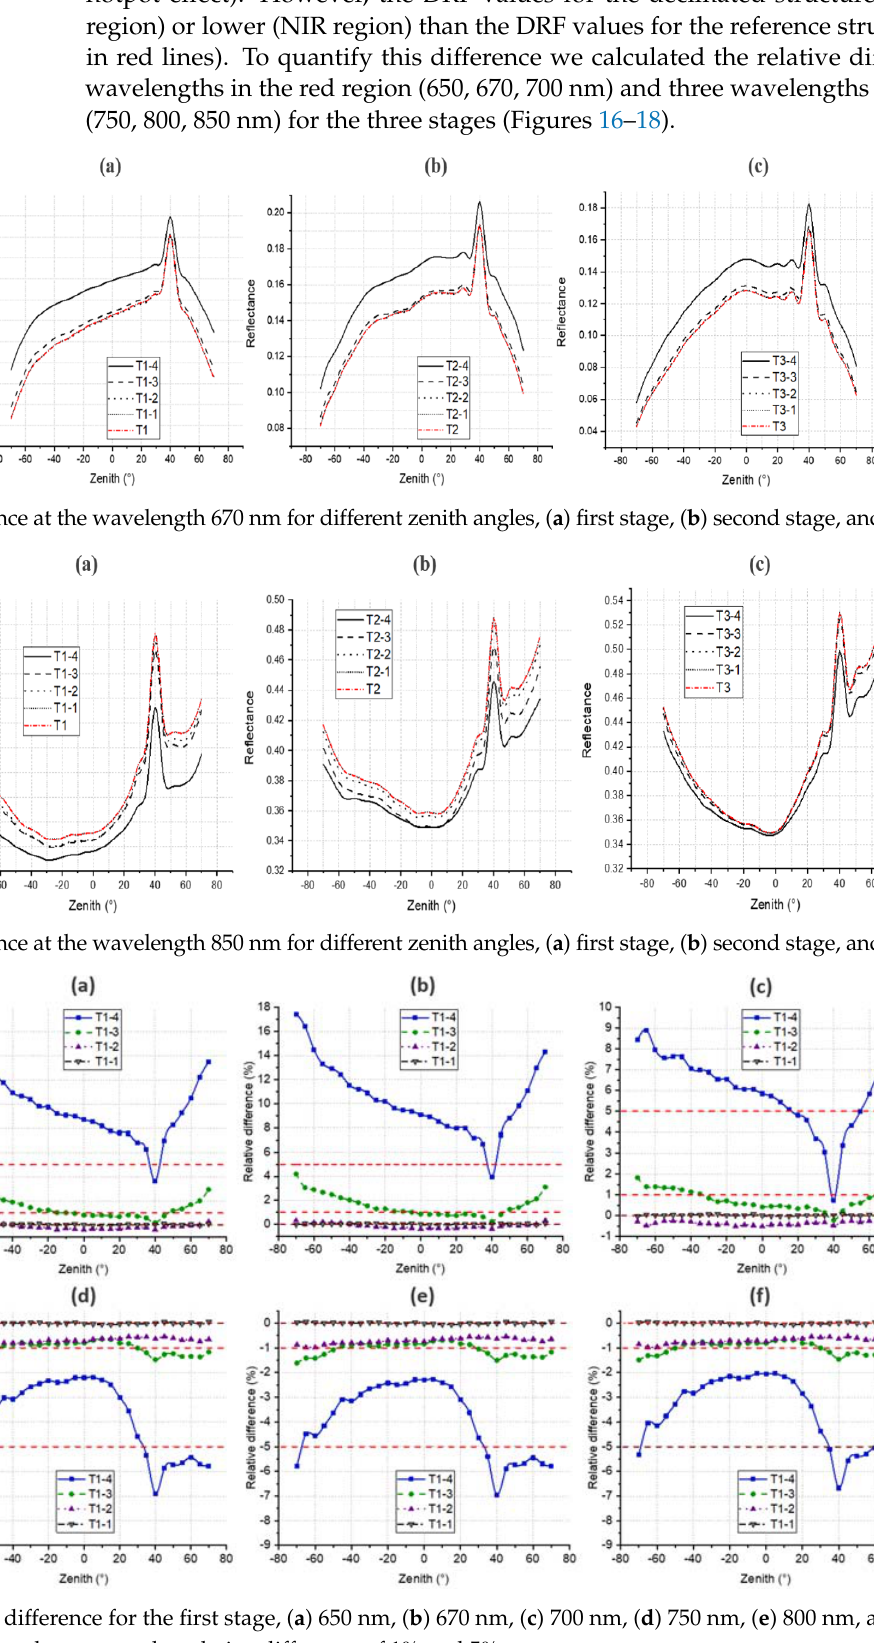
The dashed lines in red represent the relative difference of 1% and 5%. Figure 16. Relative difference for the first stage, ( a ) 650 nm, ( b ) 670 nm, ( c ) 700 nm, ( d ) 750 nm, ( e ) 800 nm, and ( f ) 850 nm.